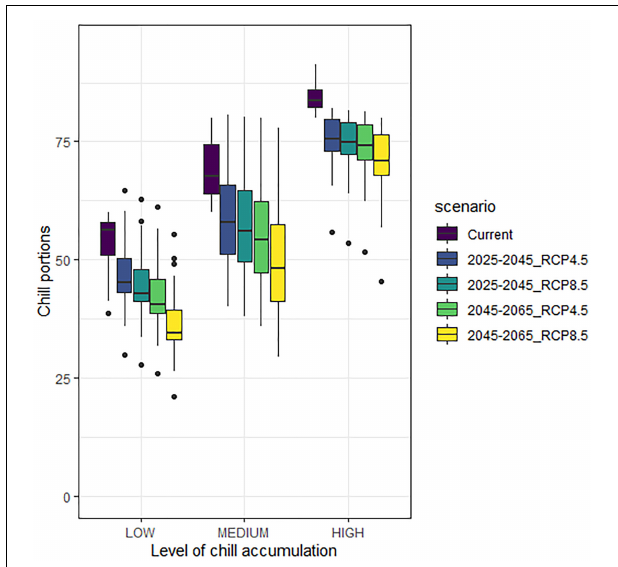
FIGURE 3 | Boxplots of accumulated chill in all scenarios for low ( < 60 portions), medium (between 60 and 80 portions), and high ( > 80 portions) chill accumulation stations, referred to the current